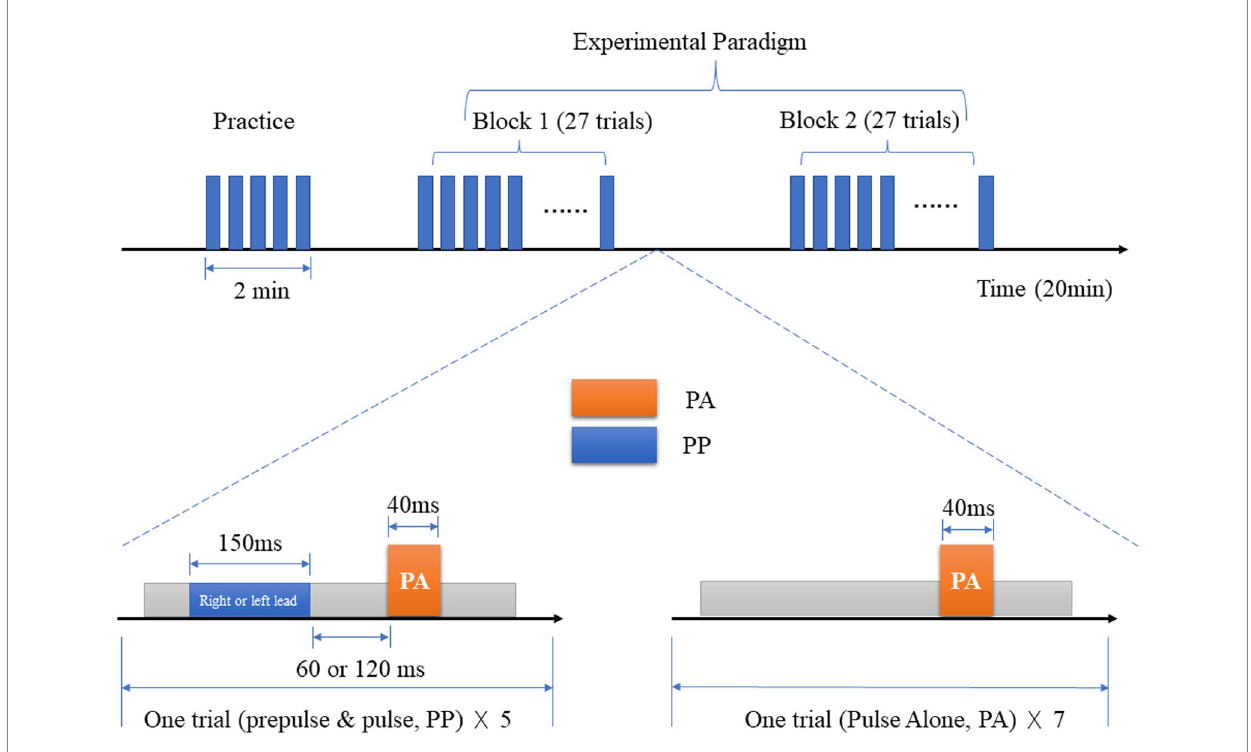
FIGURE 1 Modified experimental paradigm of prepulse